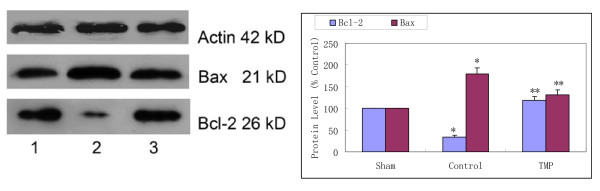
Effect of TMP on expression of Bcl-2/Bax proteins in spinal cord at the 48th hour reperfusion. Western analysis was carried out as described under Methods and the blots are shown in the upper right hand corner. Lane 1 represents sham group; Lane 2 represents vehicle control group; Lane 3 represents TMP group. The bars depict densitometry analyses of Western Blots from four independent experiments. Ischemia reperfusion obviously reduced Bcl-2 expression and increased Bax expression compared with the sham group. *P < 0.01, vs sham group; **P < 0.01, vs control group.